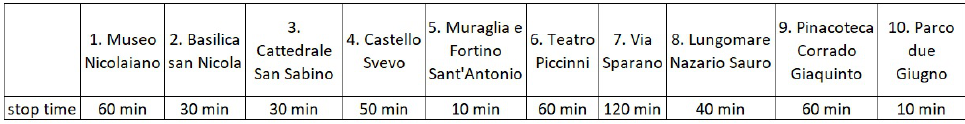
Figure 13. Stop time at each PoI.